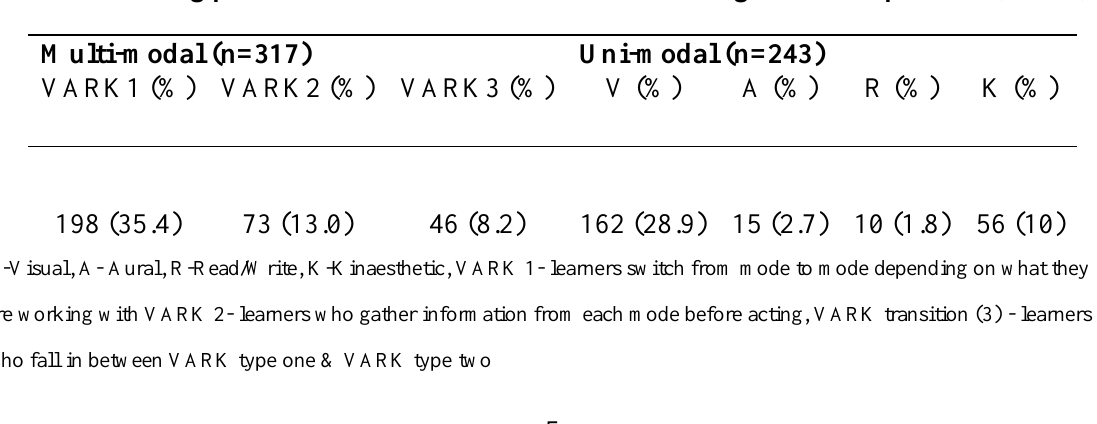
Table 1. Learning preferences of medical students according to VARK profiles